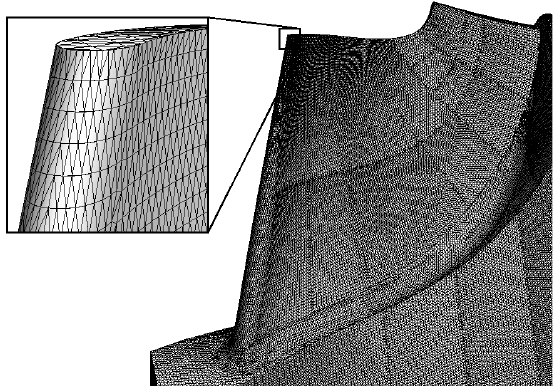
Figure 11. Tesselated surface mesh.